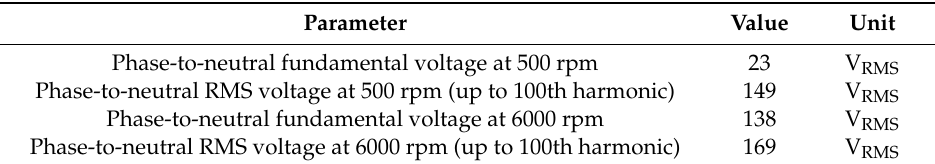
Table 2. Motor input voltages at each testing speed. Parameter Value Unit Phase-to-neutral fundamental voltage at 500 rpm 23 V RMS Phase-to-neutral RMS voltage at 500 rpm (up to 100th harmonic) 149 V RMS Phase-to-neutral fundamental voltage at 6000 rpm 138 V RMS Phase-to-neutral RMS voltage at 6000 rpm (up to 100th harmonic) 169 V